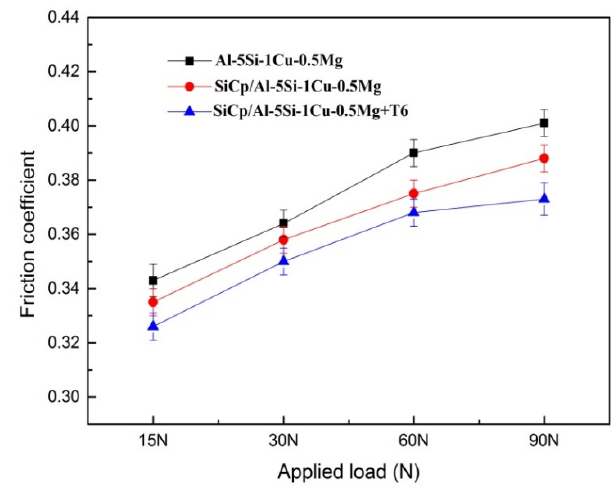
Table 3. Detailed Coefficient of friction (COF) values for samples at various applied loads.